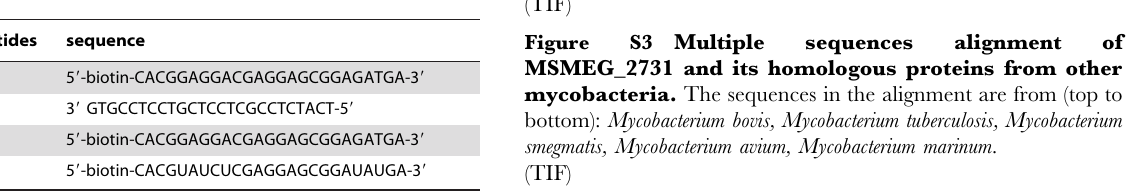
Figure S3 Multiple sequences alignment